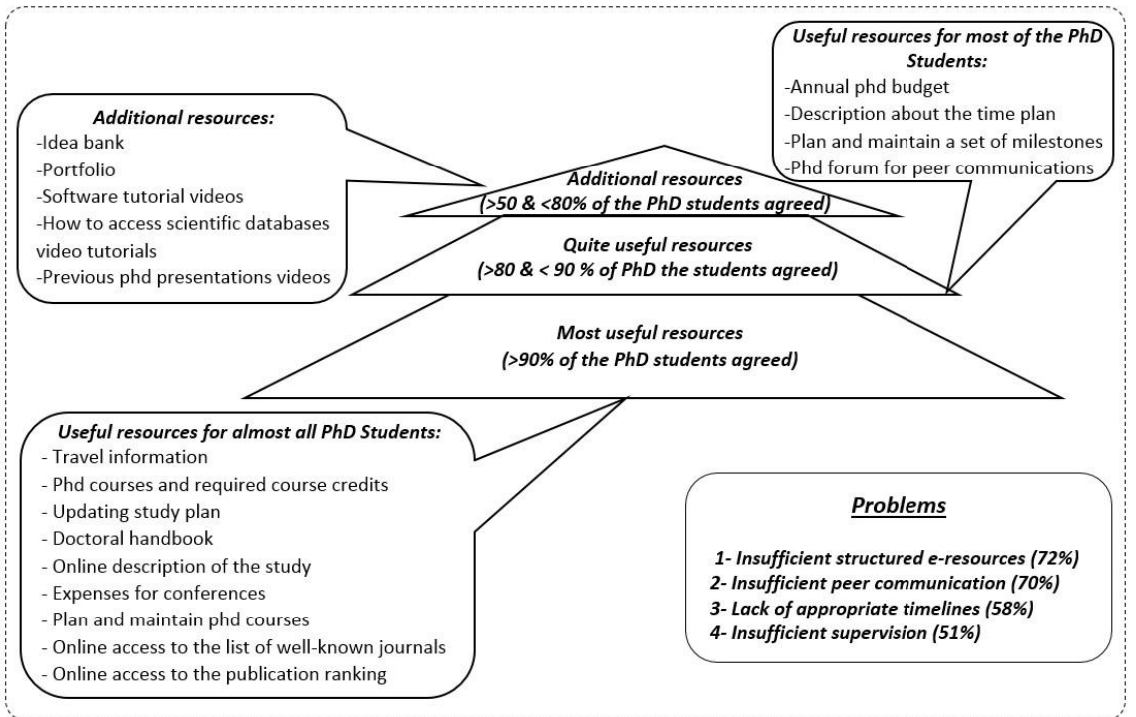
Figure 3. The categorized resources into three different levels based on the respondents’ perspectives (discussed in Tables 1 and